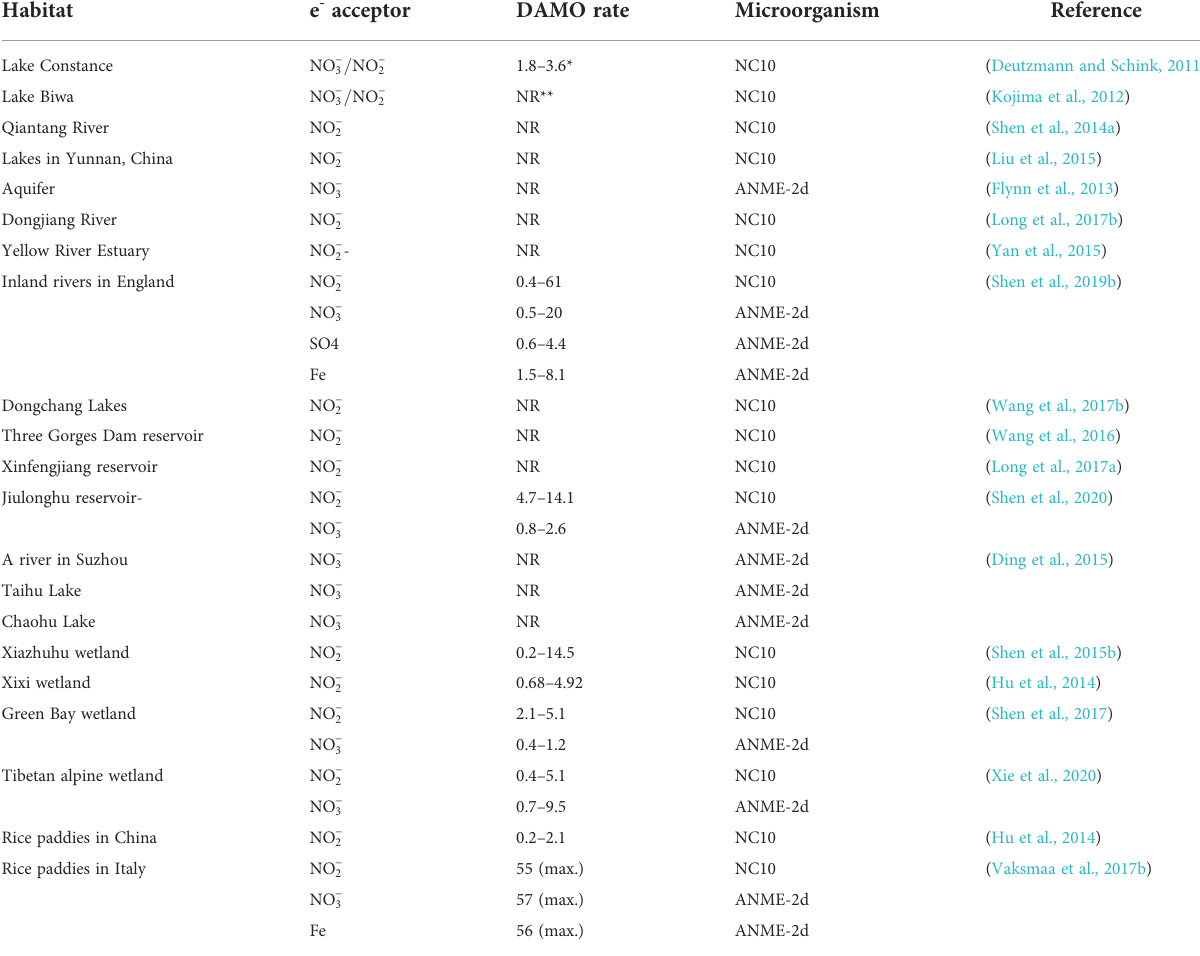
TABLE 3 Nitrite- and nitrate-dependent DAMO rates and microorganisms in freshwater habitats.